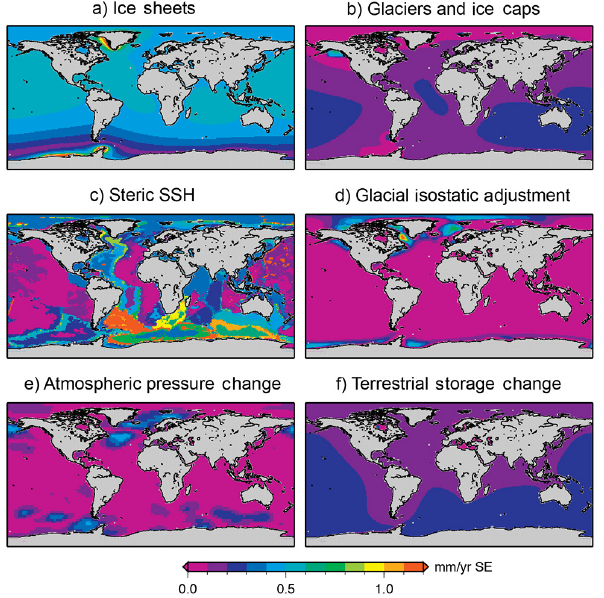
Figure 3. Regional sea-level uncertainties (mmyr − 1 ) over the pe- riod 1961–2003 for (a) ice sheets, (b) glaciers and ice caps, (c) steric change, (d) glacial isostatic adjustment, (e) atmospheric pressure loading, and (f) terrestrial water storage change from groundwater extraction and reservoir impoundment. Accompanying global mean values in Table 2.